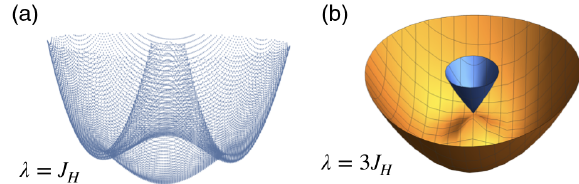
FIG. 5. Configuration d 3 . Energy surfaces for different ratios of λ and J , g ¼ B ¼ 1 . One may note three JT minima for λ ¼ J H (corresponding to compressed octahedra), but already for λ ¼ 3 J they become nearly indistinguishable and the energy surface H resembles the Mexican hat.